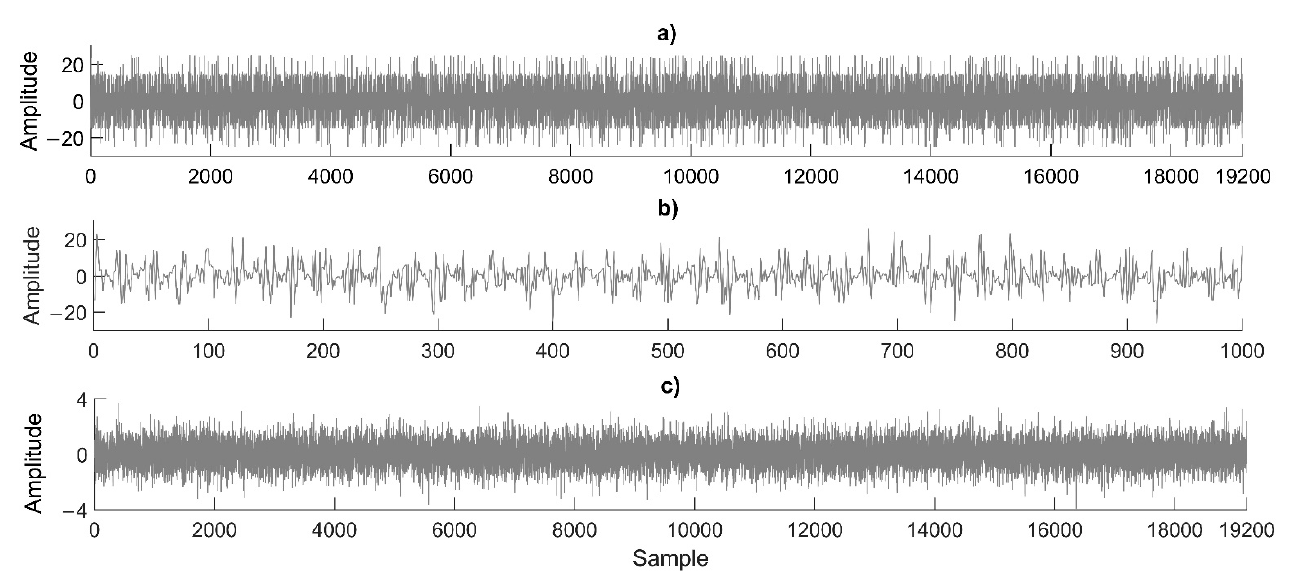
Figure 4. Cryptogram: ( a ) complete cryptogram with noise, ( b ) first 1,000 data points of cryptogram, and ( c ) AWGN noise added.